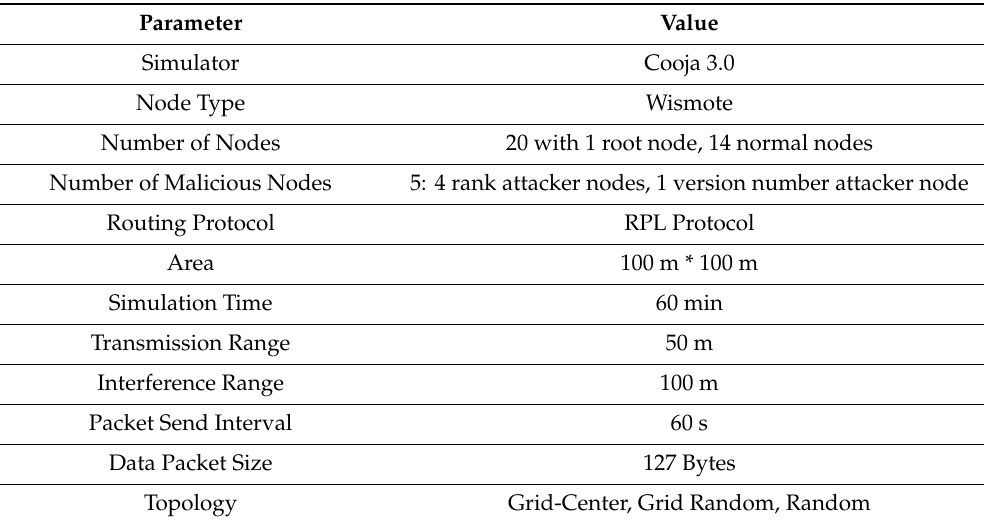
Table 2. The Simulation Model